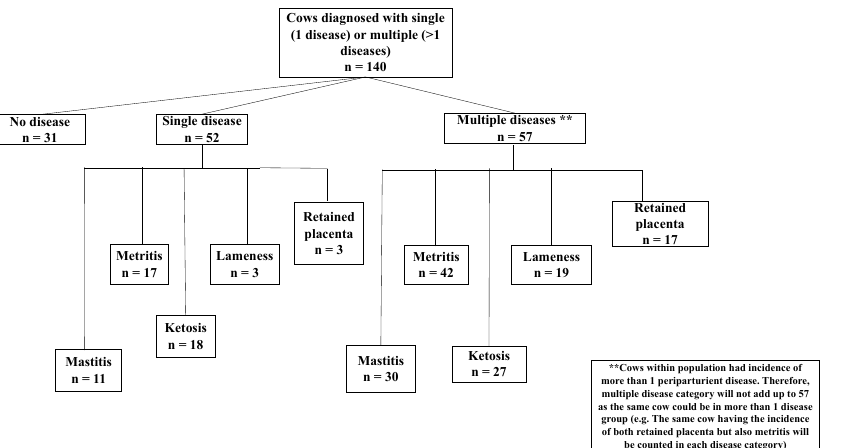
Figure 2. Flow chart of incidence rate of each of five periparturient diseases (i.e., mastitis, metritis, ketosis, lameness, retained placenta) in cows diagnosed with single disease (one disease only), multiple diseases (two diseases or more) and no diseases. Note: Cows may have been diagnosed with one or more postpartum diseases (i.e., the same cow could have been classified as retained placenta and metritis). Table 1. Frequencies of the incidence rate for cows diagnosed with periparturient disease between SCC groups and number of diseases.